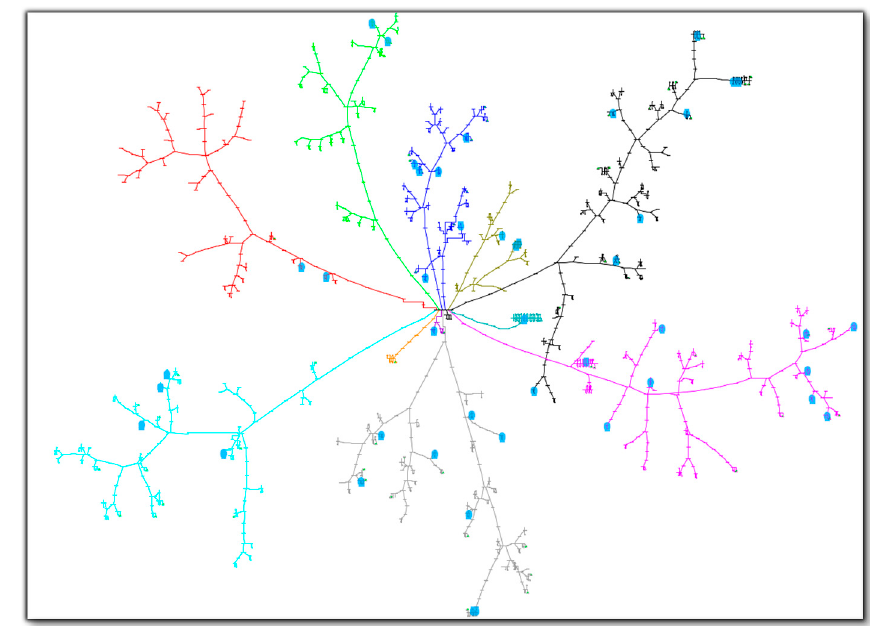
Figure A11. Use case 8—Location of PVs.